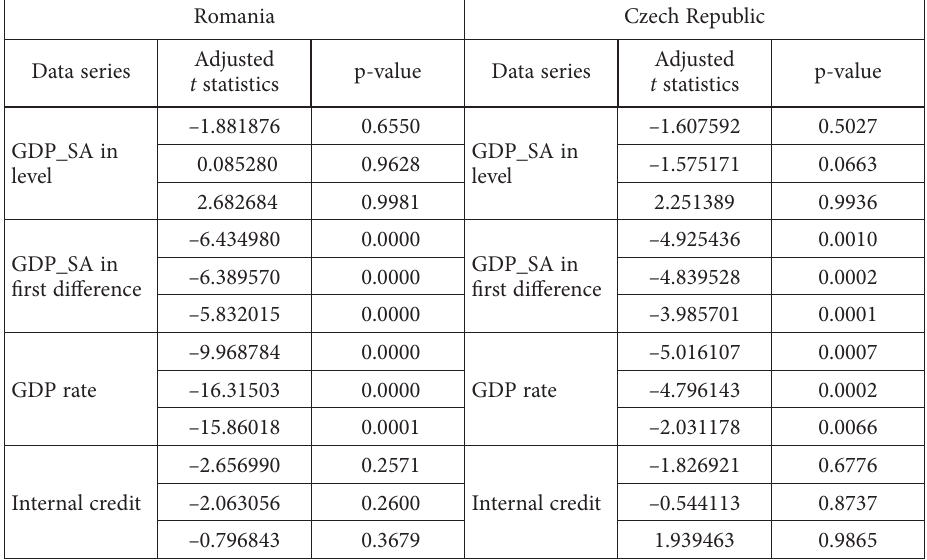
Table 3. Results of Phillips-Perron test for checking the presence of unit roots (source: authors’ calculations)